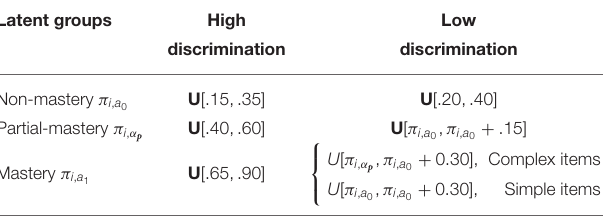
TABLE 1 | The table of selecting π i , c for item by class matrix. Latent groups High Low